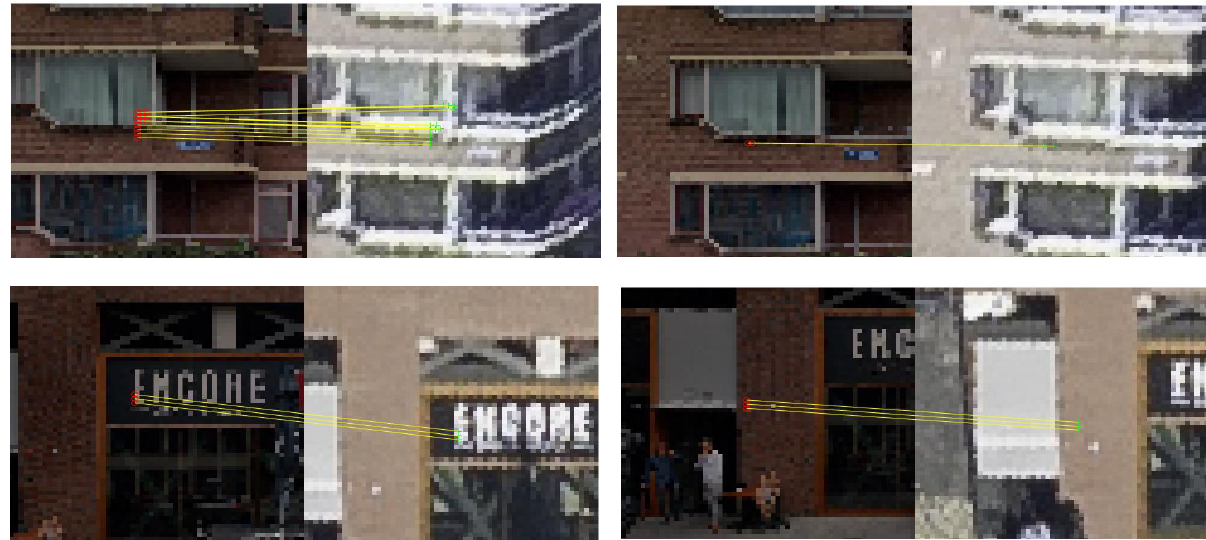
Figure 9. Four exemplary registration results between MM and aerial oblique images. The MM images are on the left hand side, the aerial oblique images on the right hand